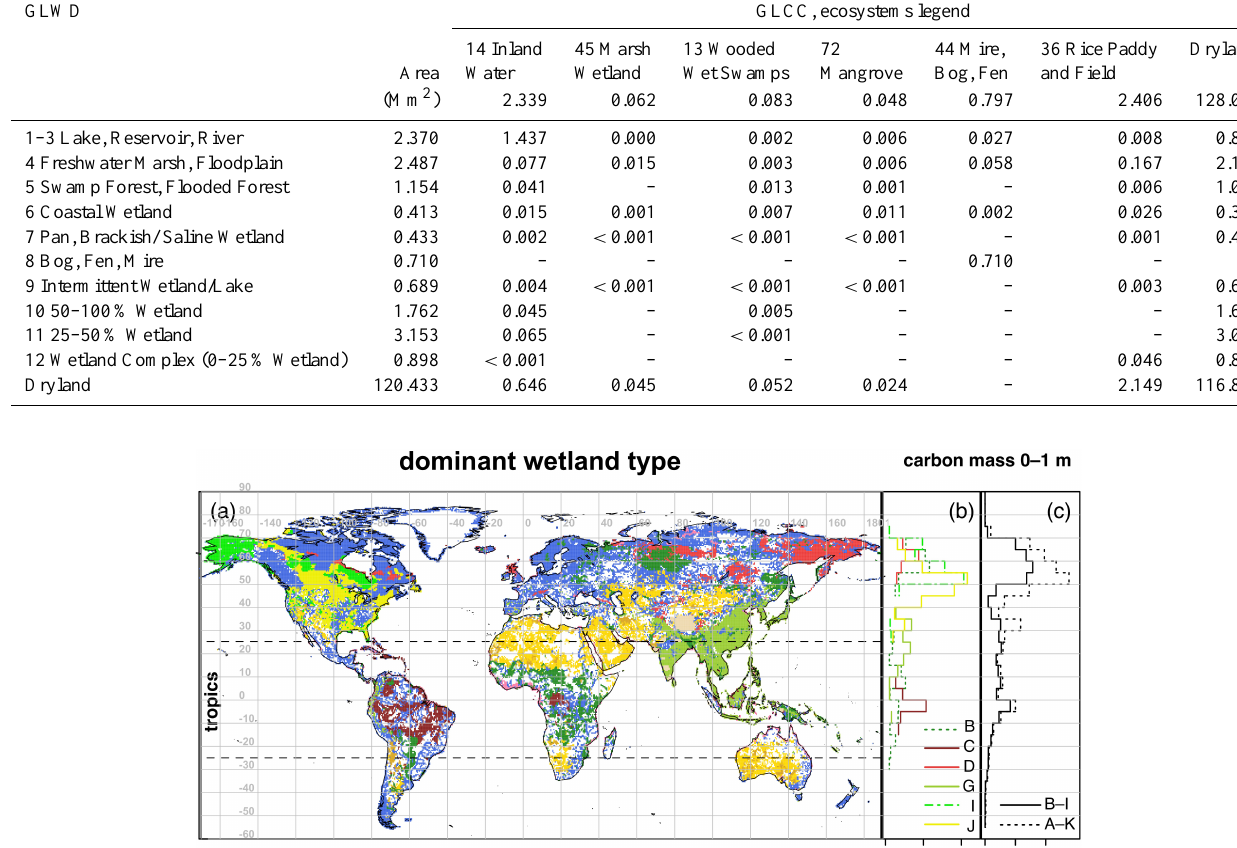
Table 6. Area and spatial overlap of wetland types in GLWD and GLCC (grid cell area, Mm 2 ) within the extent of the HWSD. GLWD